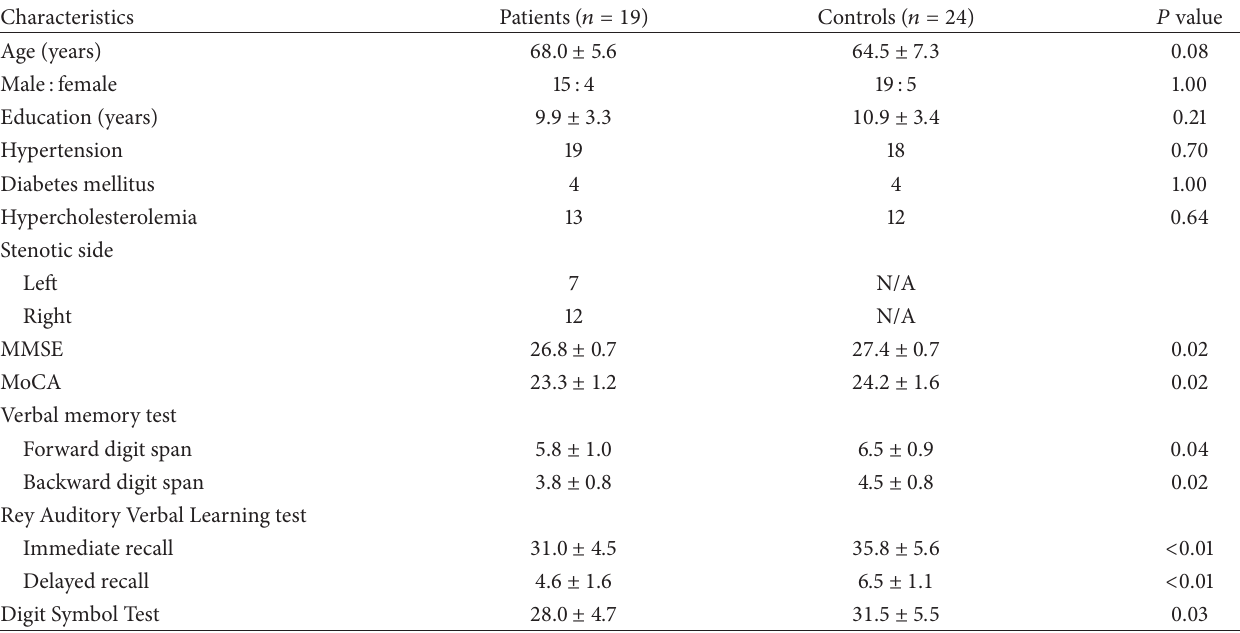
Table 1: Basic demographics and cognitive test scores of enrolled subjects.